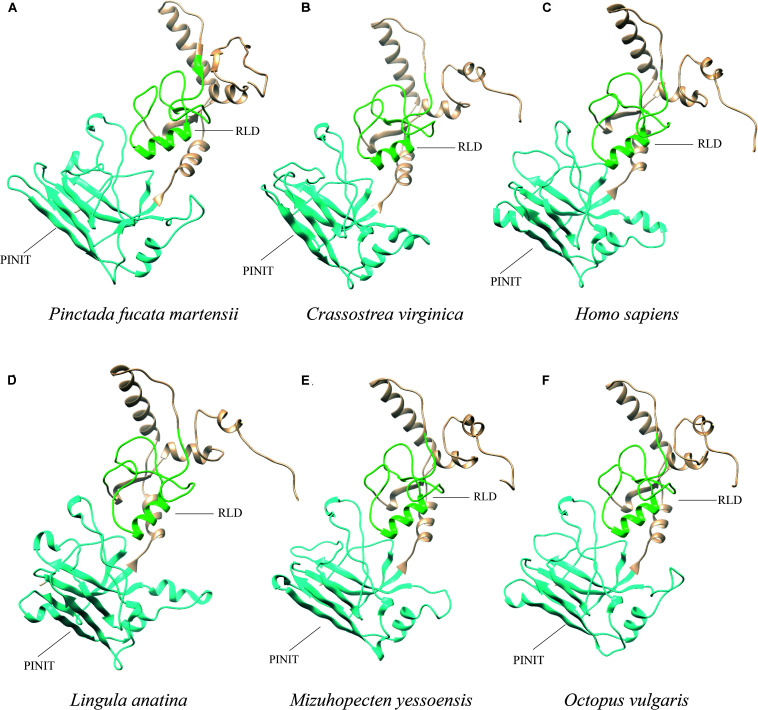
Ribbon representation of PIAS protein sequences from different species. (A–F) Show the protein sequences from P. f. martensii, Crassostrea virginica (XP_022331287.1), Homo sapiens (AAI11061.1), Lingula anatina (XP_013385044.1), Mizuhopecten yessoensis (XP_021340266.1), and Octopus vulgaris (XP_029634642.1), respectively. The blue and green represented the PINIT and RLD domains, respectively.